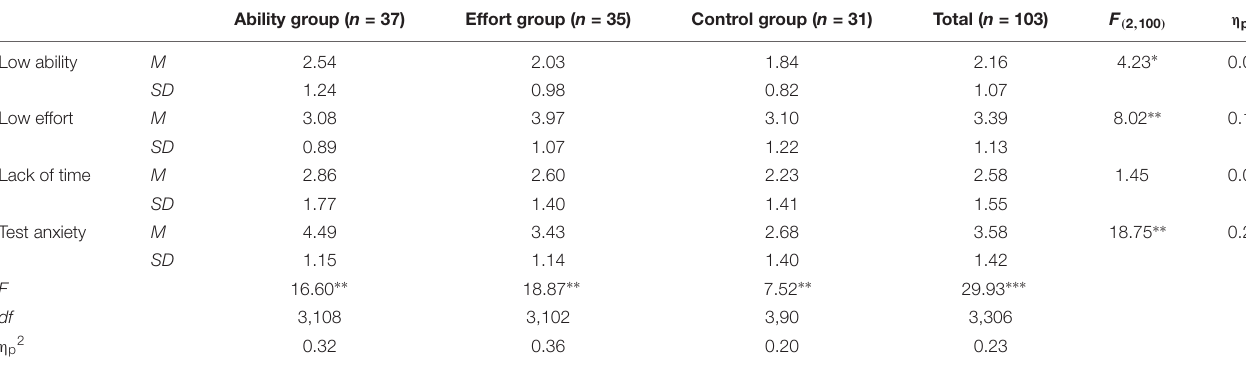
TABLE 2 | Descriptive statistics for children’s failure